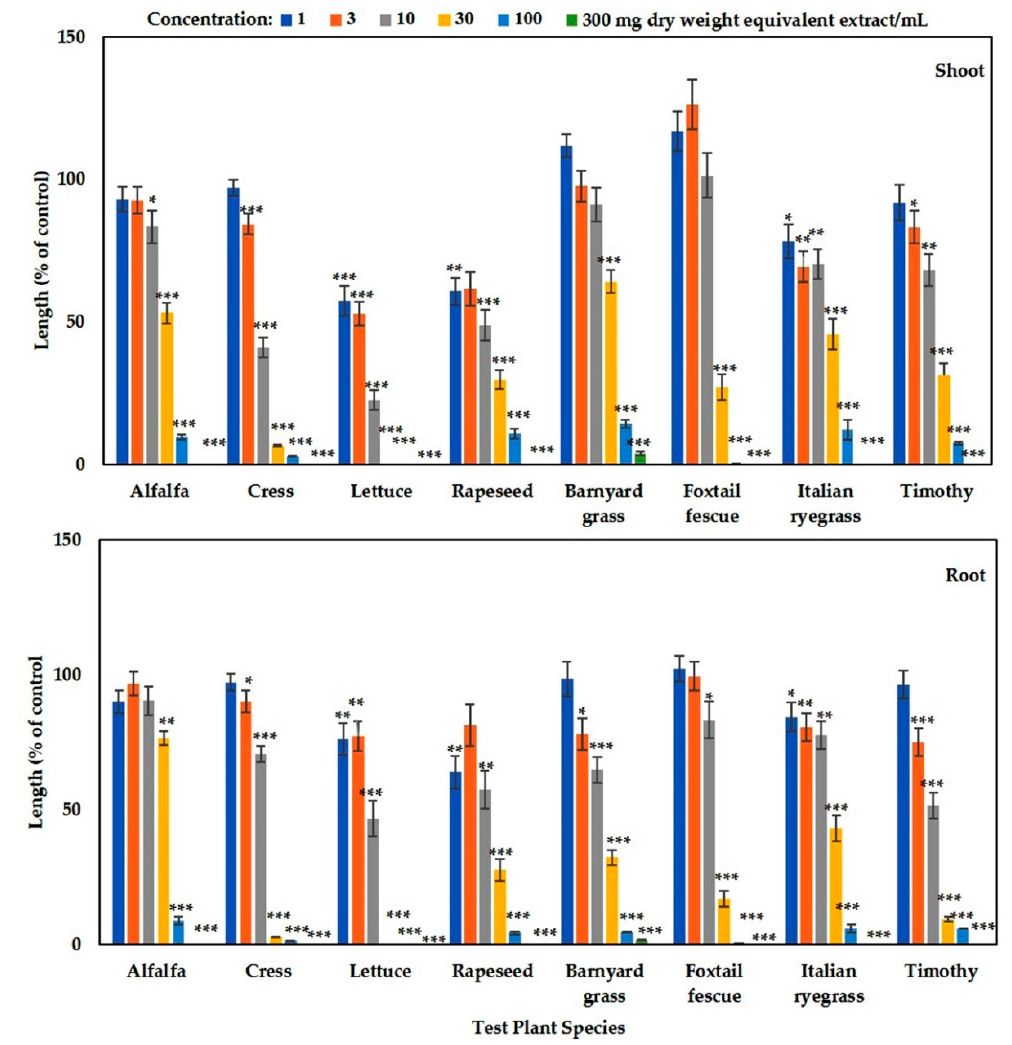
Figure 2. Growth inhibitory e ff ects of Wedelia chinensis plant extracts on the shoot and root growth of lettuce, alfalfa, cress, rapeseed, barnyard grass, timothy, Italian ryegrass, and foxtail fescue: the tested species were exposed to the concentrations of 1, 3, 10, 30, 100, and 300 mg DW equivalent extracts of Wedelia chinensis / mL. The values are mean ± SE for each treatment from the two independent experiments with 3 replications (10 seedlings for each replication) for every experiment ( n = 60) that is displayed. Asterisks signify important variations between treatments and control: * p < 0.05, ** p < 0.01, and *** p < 0.001 (ANOVA one-way and LSD test by post hoc). Table 1. The I 50 values of the aqueous methanol extracts of Wedelia chinensis against shoot and root growth of the tested species.